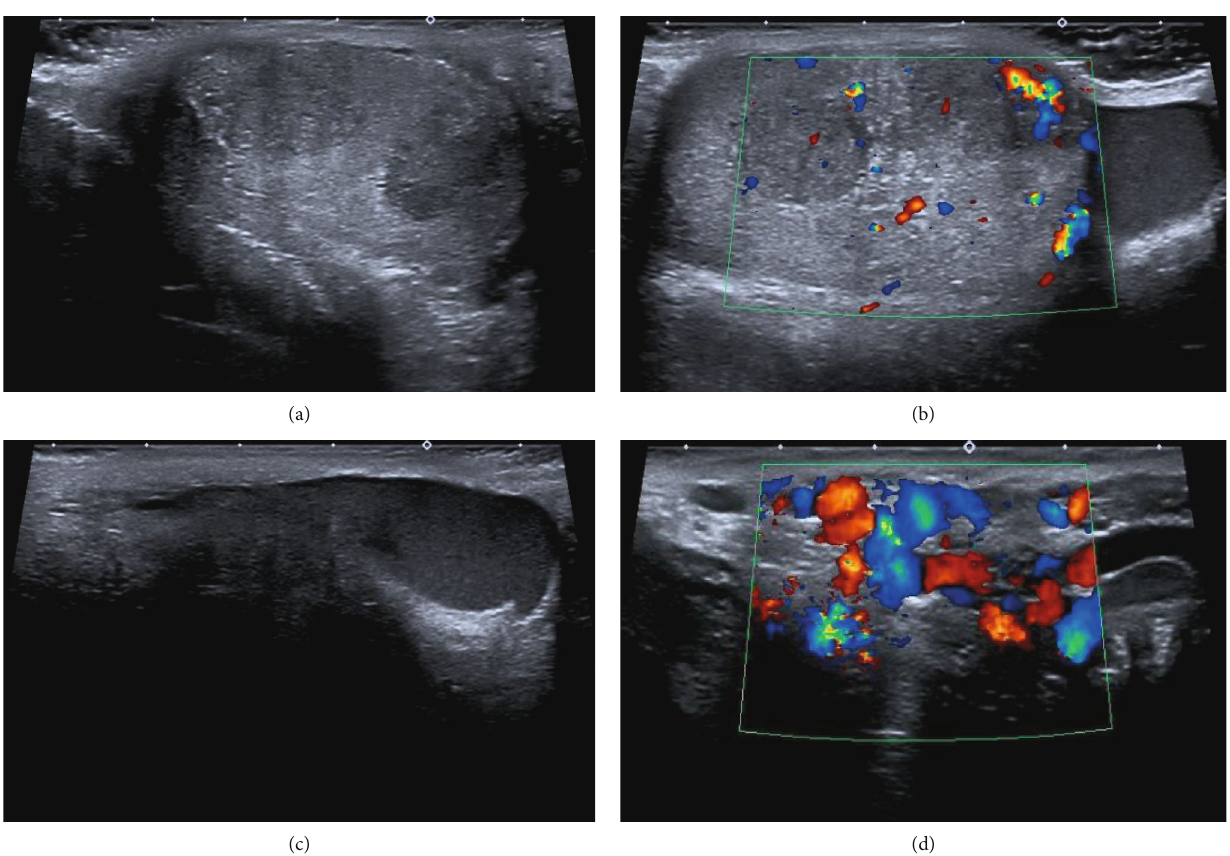
Figure 1: Ultrasound. (a – c) Enlarged right testicle (estimated volume of 32 cc) and a highly heterogenous parenchyma with multiple nodules, most of them hypoechogenic and demonstrating high vascularization. A right complex hydrocele, suggestive of an hematocele, is also seen. (d) Doppler analysis found bilateral varicocele without signi fi cant re fl ux with Valsalva